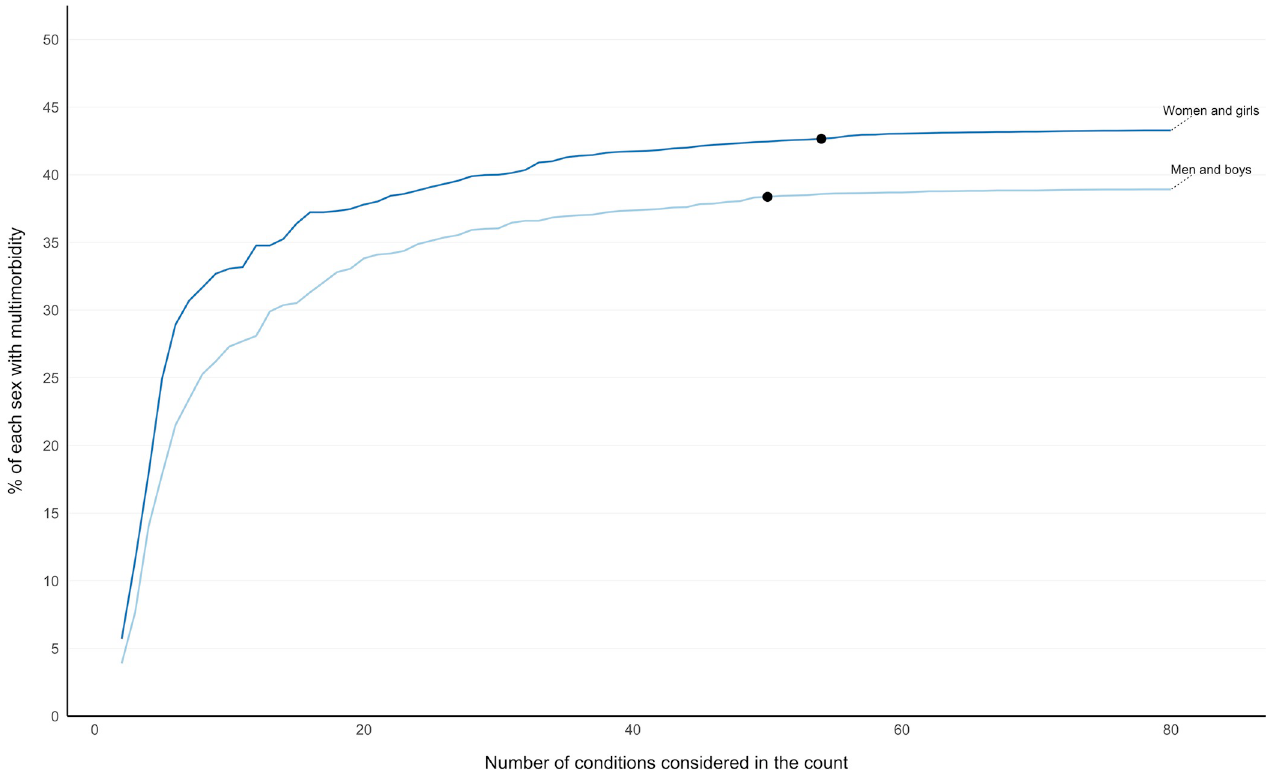
Fig 4. Sex-stratified multimorbidity prevalence according to number of conditions considered following direct age standardisation, reporting the ceiling effect where adding additional conditions had little impact on prevalence. Labelled coloured lines represent multimorbidity prevalence calculated when considering different numbers of conditions in the count ranging from 2 to all 80 conditions stratified by sex. Black dots represent the number of conditions at which RR > 0.99 of multimorbidity prevalence of having the same multimorbidity prevalence when all 80 conditions were considered (ceiling effect): women and girls at 54 conditions and men and boys at 50 conditions. Direct age standardisation where the whole study cohort was the standard population was applied (see S2 Fig for unstandardised rates). RR, relative risk.